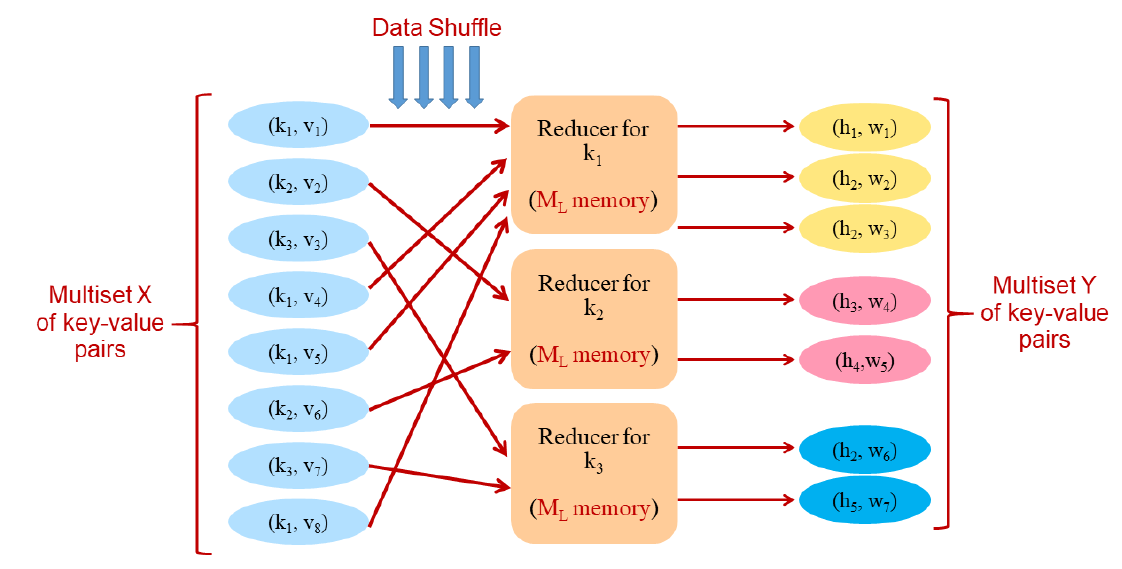
Figure 1. An example of a MapReduce round, transforming a multiset of 8 key-value pairs (over 3 keys) into a multiset of 7 key-value pairs (over 5 keys). At most M A memory overall can be employed during the